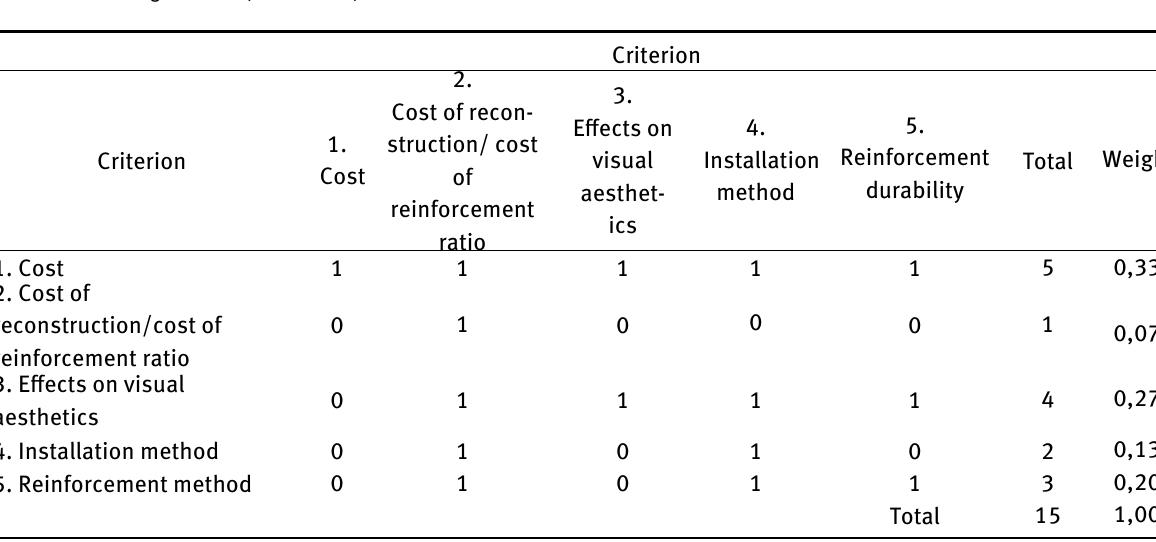
Table 7: Criteria weight values (own studies)